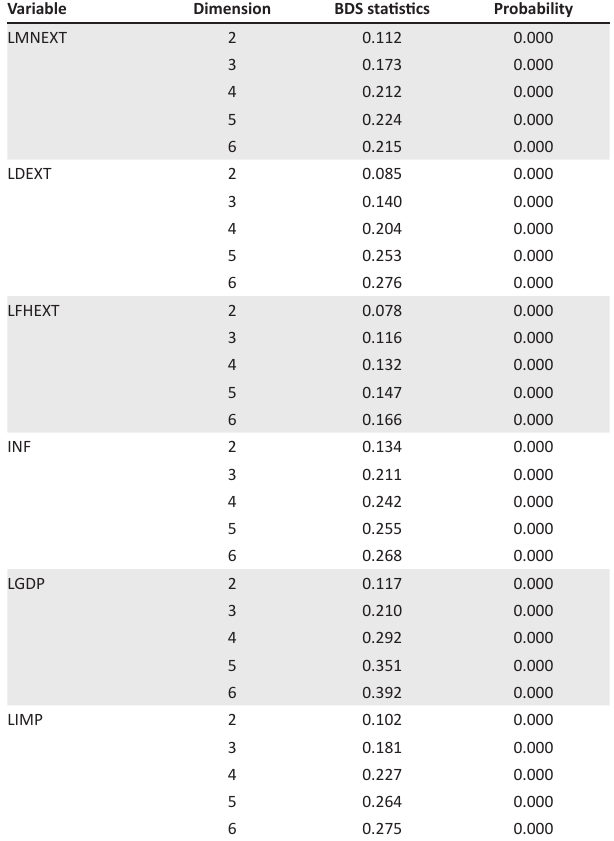
TABLE 3: BDS test for non-linearity. Variable Dimension BDS statistics